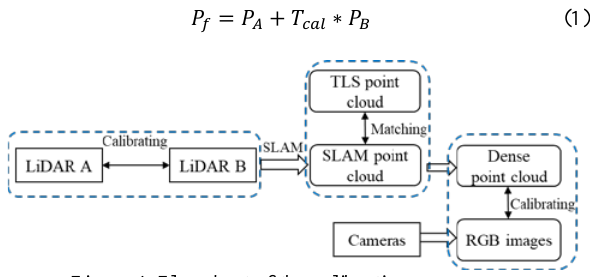
Figure 4. Flowchart of the calibration process.